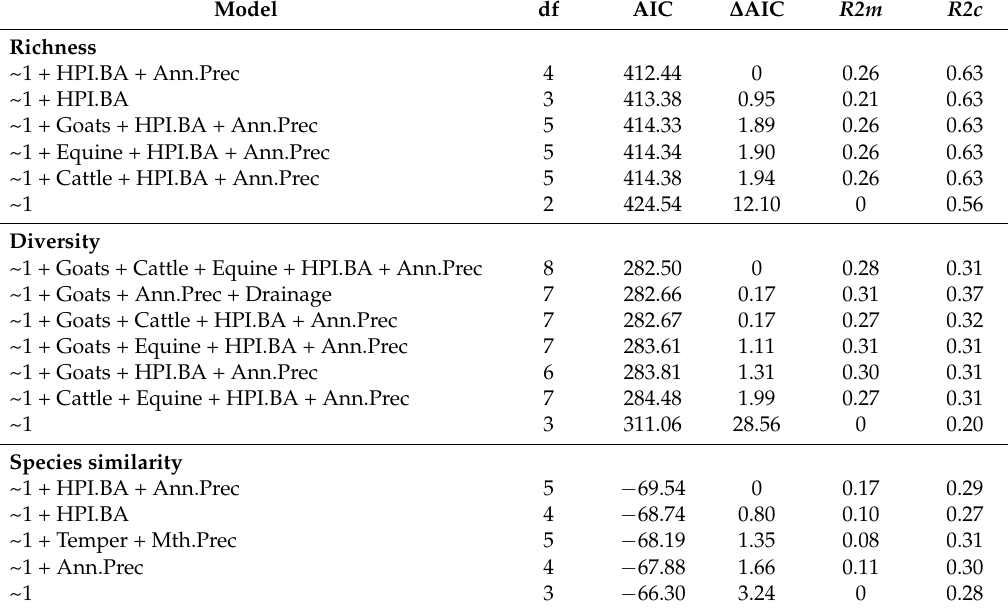
Table 2. Best models of the five response variables. df = degrees of freedom; AIC = Akaike’s information criterion; ∆ AIC = Delta Akaike’s information criterion; R2m = marginal variance explained by fixed effects; R2c = conditional variance explained by random and fixed effects. In models with HPI.BA,